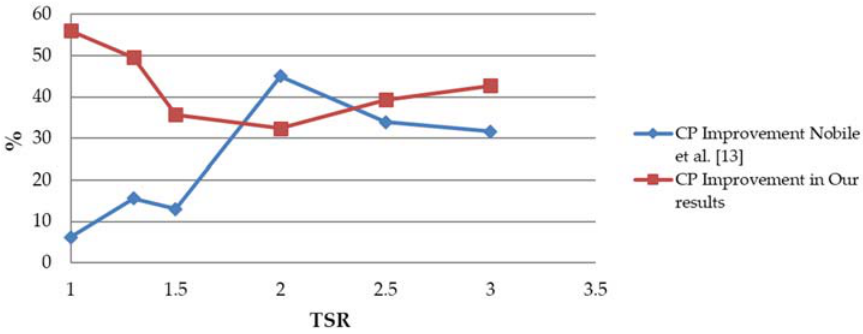
Figure 32. Comparison of the C P average improvement in this study with the Nobile et al. [13].